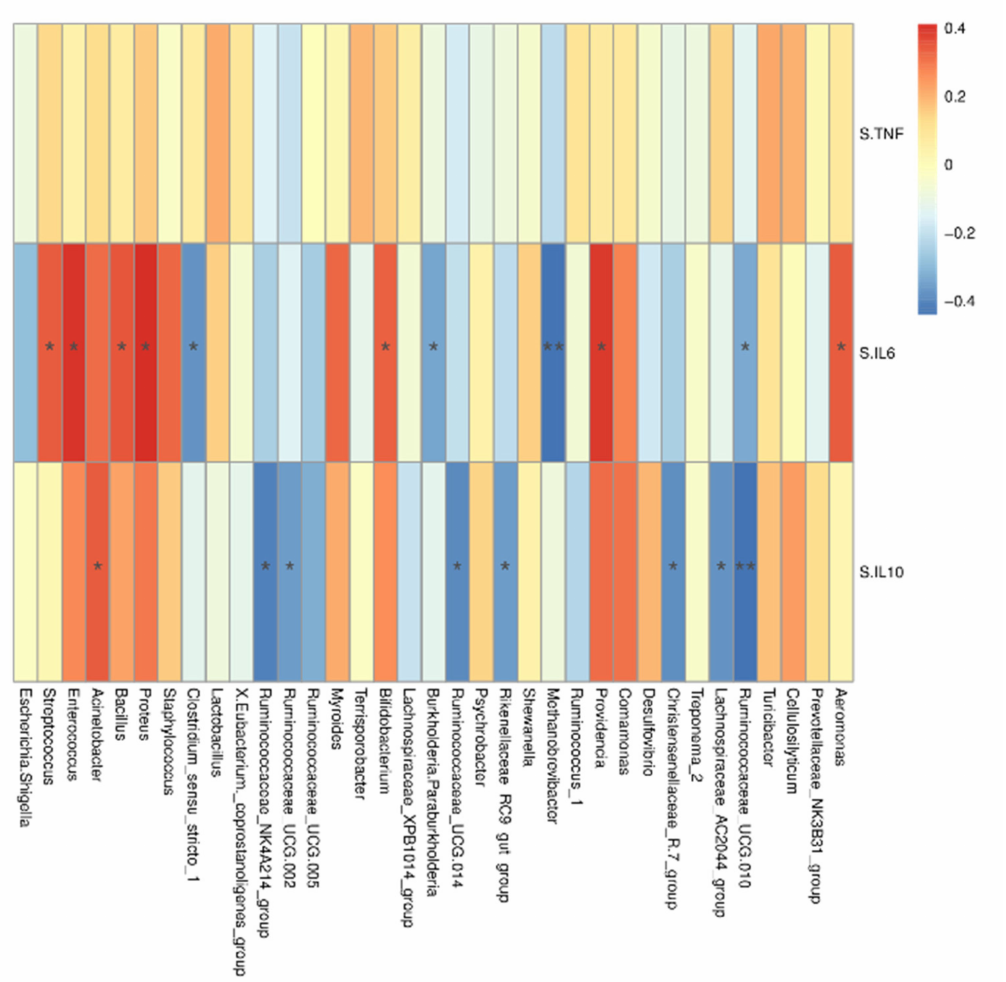
Figure 4. Heatmap of the spearman r correlations between the vaginal microbiota (genera level) significantly modified by metabolic parameters of sow. Data are presented as means ± SD (n = 6). * p < 0.05; ** p < 0.01 (following the Spearman correlation analysis). S.TNF = serum TNF- α , S.IL6 = serum IL-6, S.IL10 = serum